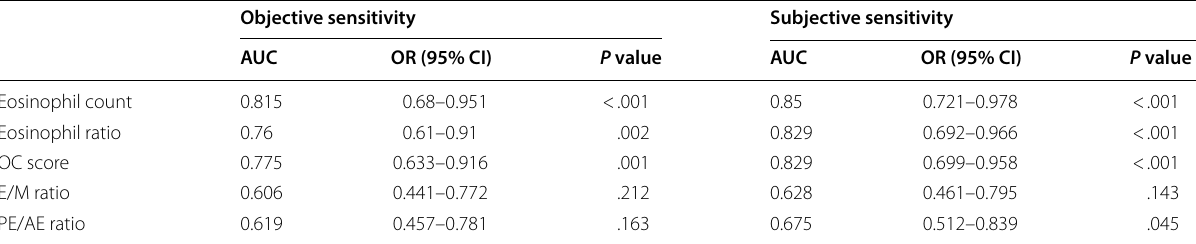
Table 4 AUCs for individual clinical markers